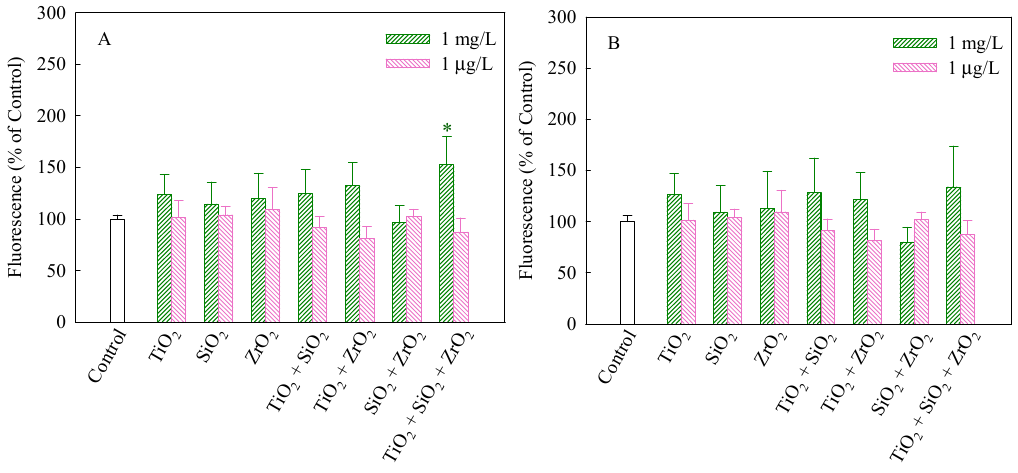
Figure 2. Mitochondrial membrane potential ( A ) and cellular membrane permeability ( B ) of S. obliquus exposed to 1 mg/L and 1 μ g/L of NPs alone, 1 mg/L and 1 μ g/L of single NPs in binary combination and 1 mg/L and 1 μ g/L of single NPs in ternary combination. * indicates statistically significant difference from control ( p < 0.05).